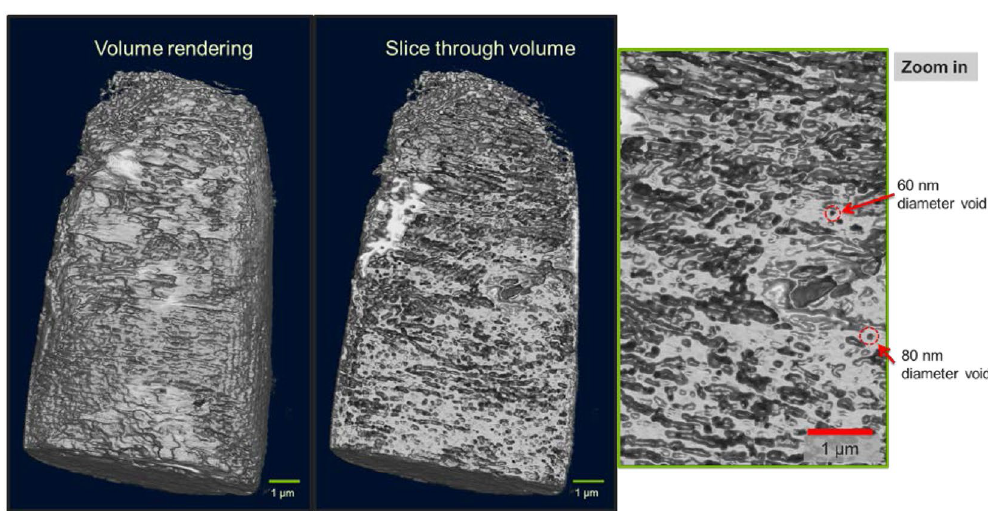
Figure 6. X-ray tomography imaging of tooth sample using SiS ZnO as contrast enhancement. Reconstruction results showing sequence of total volume rendering, a slice through the volume, and a zoom into the section of the slice highlighting the presence of detailed nanoscale features and well-defined pores as small as 60 nm to 80 nm in diameter within the